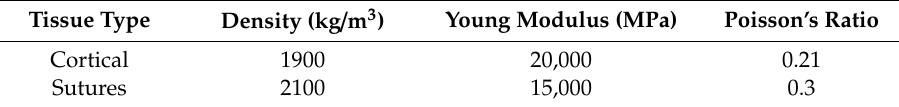
Table 1. Cortical bone and sutures elastic material properties.